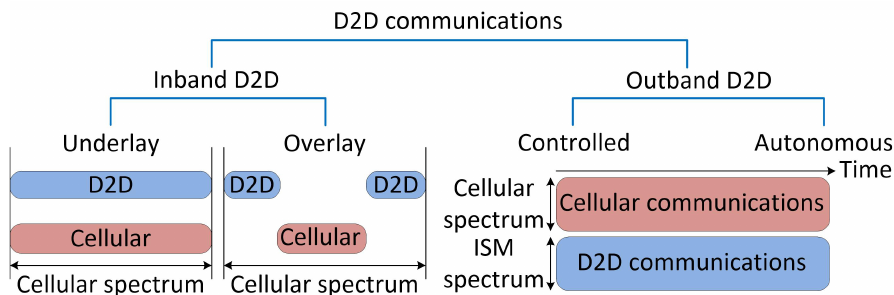
Figure 1. Classification of D2D